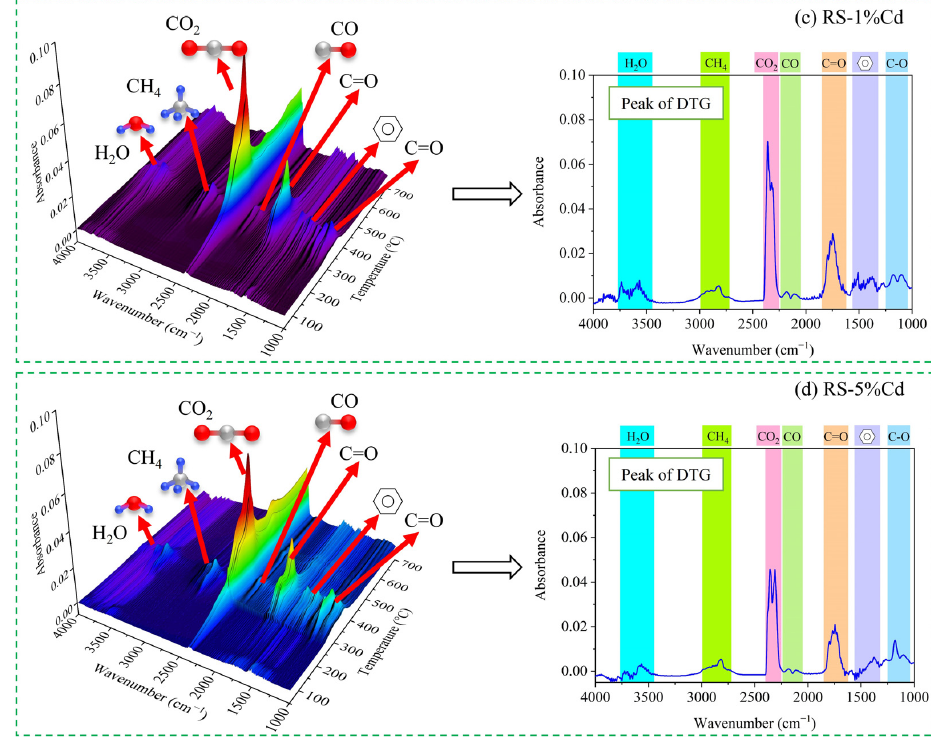
Figure 9. The FTIR spectrum of pyrolytic volatiles from ( a ) RS, ( b ) RS-0.1%Cd, ( c ) RS-1%Cd, and ( d ) RS-5%Cd. The left side is the 3D FTIR spectrums during the whole pyrolysis process at a heating rate of 20 °C·min − 1 . The right side is the extracted spectrums at the temperature corresponding to the DTG curves’ peak.